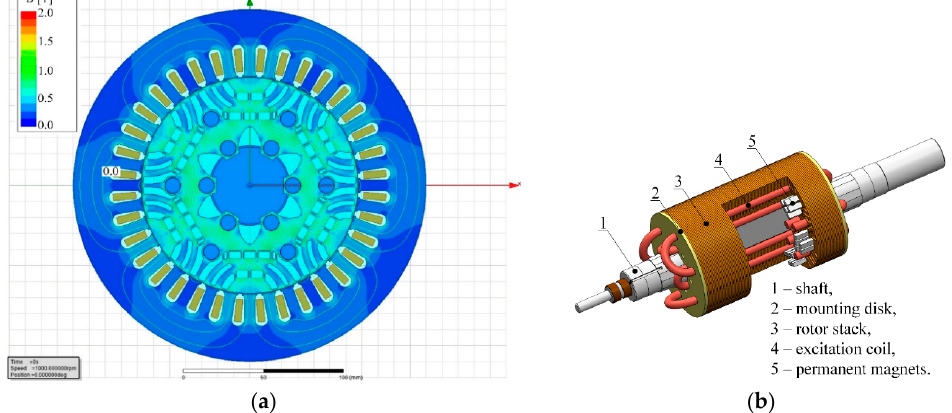
Figure 21. ( a ) Magnetic flux density distribution in the FEA model; ( b ) Concept of HESMFB machine rotor [59].